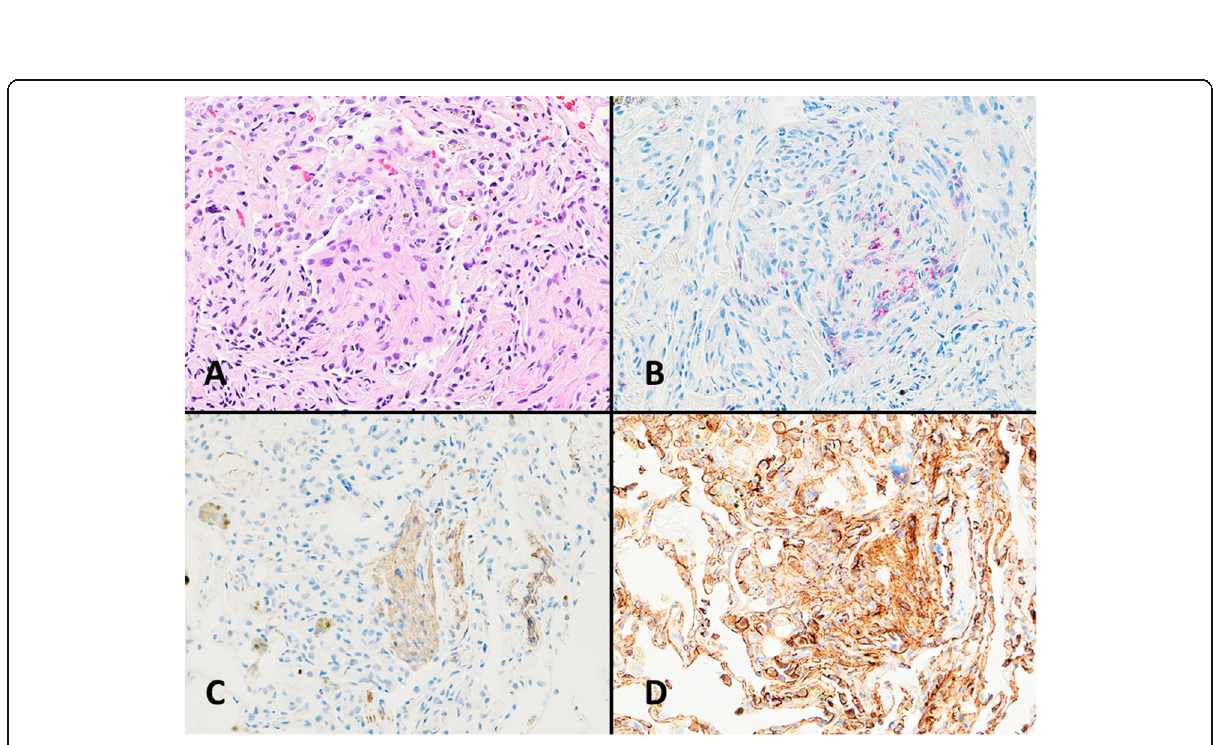
Fig. 4 Immunohistochemical studies were performed to categorize the spindle cells. These cells are positive for HMB-45 ( b ), smooth muscle actin ( c ), and show membranous and cytoplasmic staining with beta catenin ( d ). This immunophenotype is consistent with LAM ( a hematoxylin and eosin, original magnification 200X; b HMB-45, original magnification 200X; c smooth muscle actin, original magnification 200X; d beta catenin, original magnification